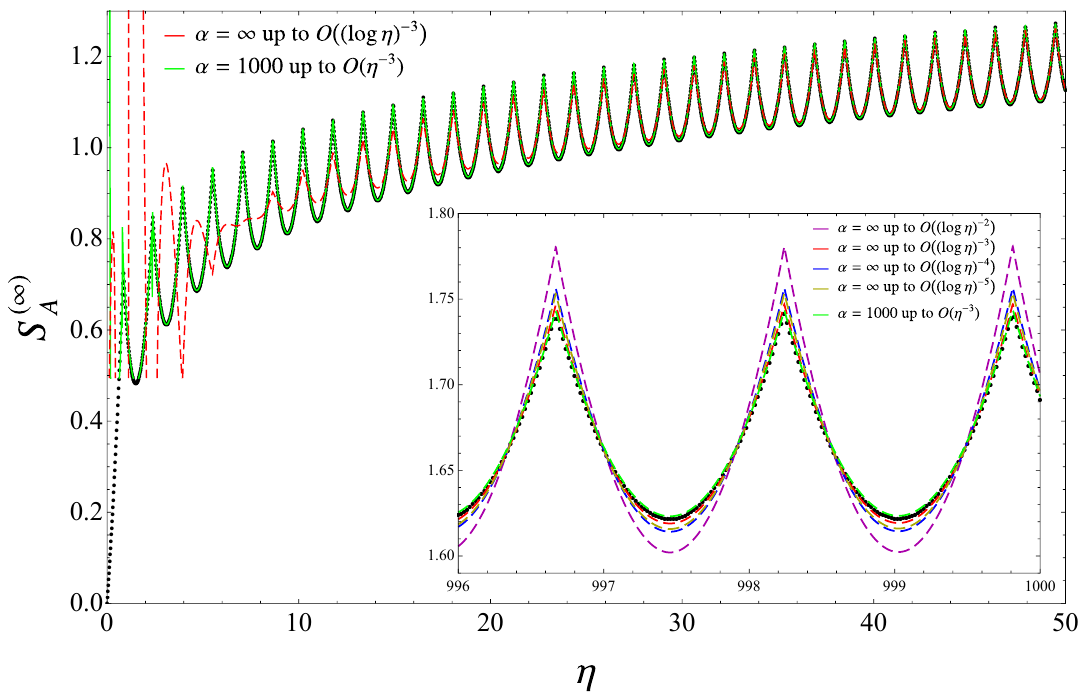
Figure 11. Single copy entanglement for large values of η